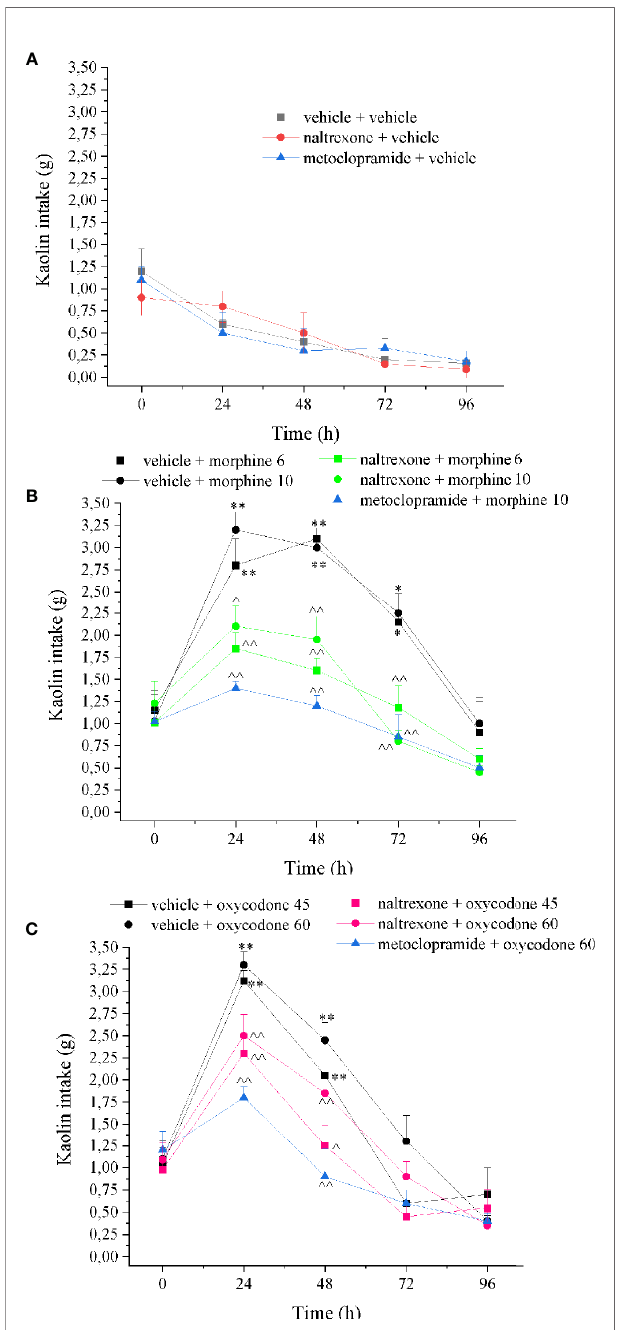
FIGURE 7 | Effect of intranasal administration of naltrexone on morphine and oxycodone induced “ pika ” phenomenon in the rat. Nausea/emesis related to opioids was evaluated as the increased of the kaolin intake expressed in grams 60 min after the administration of (A) metoclopramide (5 mg kg − 1 ) or